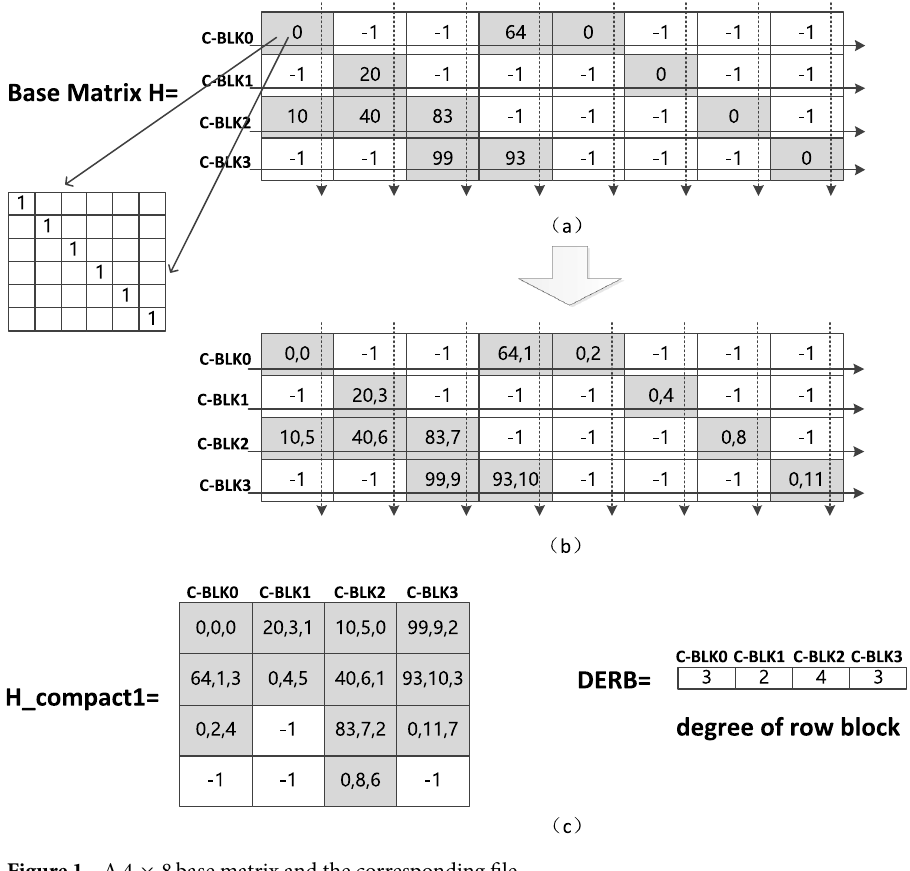
Figure 1. A 4 × 8 base matrix and the corresponding file.